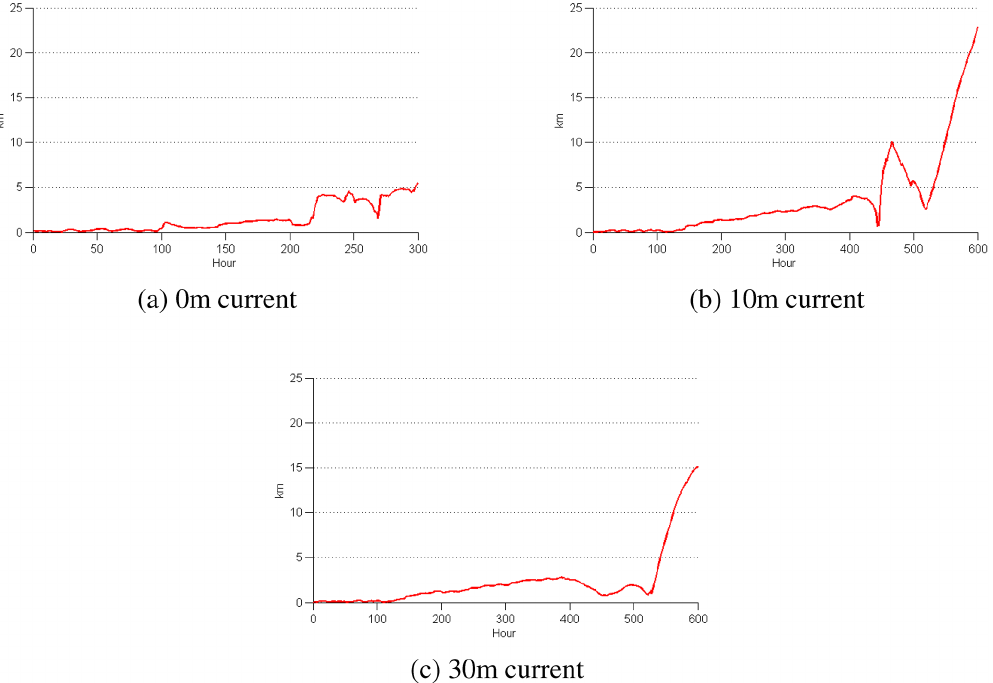
Figure 9. Distance between MEDSLIK and CranSLIK centre of mass forecasts for the Lebanon test case, using the current at different depths as the advective